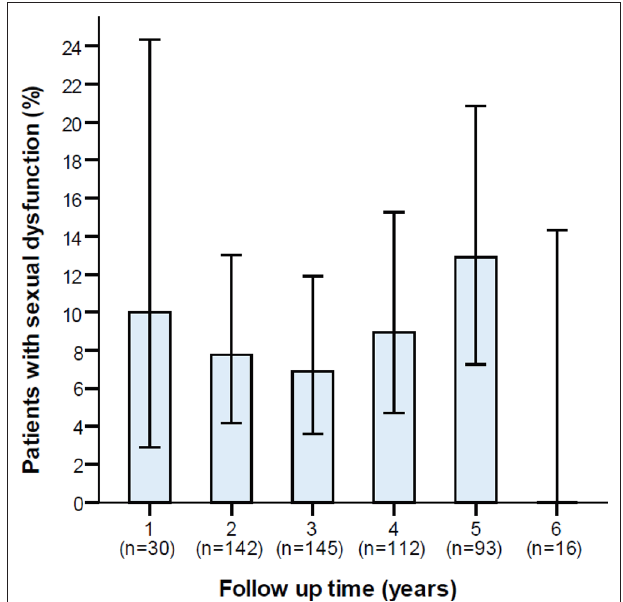
FigUre 3 | Proportion of patients with sexual dysfunction due to pain in relation to the length of follow-up. Error bars represents 95% confidence intervals.